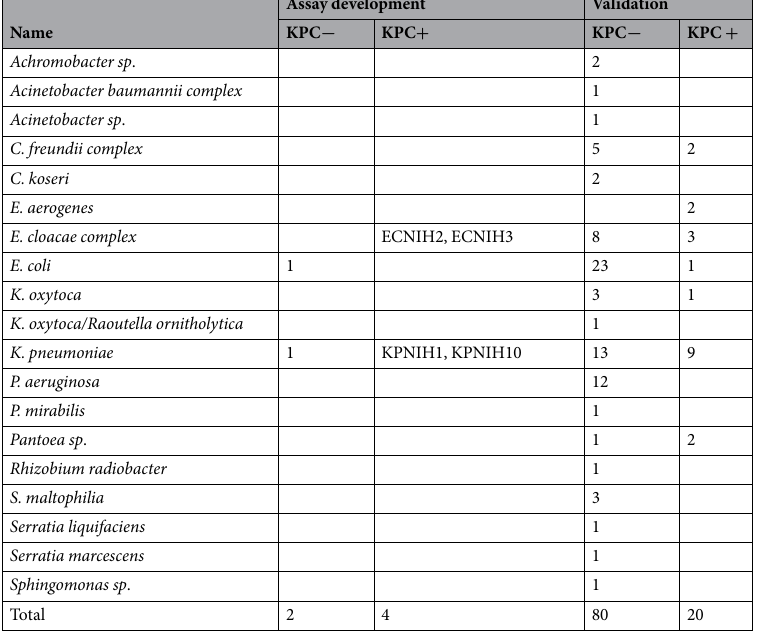
achieve better digestion efficiency with fewer missed cleavages in a short digestion time, we chose Trypsin/Lys-C mix for digestion, which was reported to improve the digestion by reducing missed lysine cleavages and improv- ing signal intensity for some peptides for accurate absolute protein quantification 31 . We compared the intensities of the 4 potential peptide markers with one KPC positive and one KPC negative isolate. Supplementary Figure 2 shows digestion protocol optimization. 1 ug enzyme was used to digest 20 uL lysate in all tests. In these experi- ments, microwave treatment did not enhance the digestion efficiency compared with water bath, consistent with previous results 29 . Trypsin/Lys-C also did not improve the detection of these 4 KPC peptides compared with Trypsin only, and longer digestion did not produce significantly higher signals on the targeted peptides. While a more complete tryptic digestion could be achieved with a longer digestion time (e.g. 4 hour or overnight), our objective in this work was to optimize the digestion protocol so that it yielded quantities of the chosen peptide markers that were sufficient for robust determination of the presence or absence of KPC protein in the shortest time, to be compatible with a clinical assay. Thus, 15 min digestion at 55 °C in water bath was chosen for all clinical isolates and was used as the standard method for the blinded validation (below). Evaluation of method performance. We tested four known bla KPC positive isolates (ECNIH2, ECNIH3, KPNIH1, KPNIH10) and two bla KPC negative isolates to study reproducibility, background signals, carryover effect, interfering peaks, and peptide stability. An in-line external standard (external positive control), composed of protein extract made from a KPC-expressing isolate (KPNIH1, as described in Materials and Methods), was tested at the beginning and end of each day, to ensure consistent instrument performance and to allow a quantita-